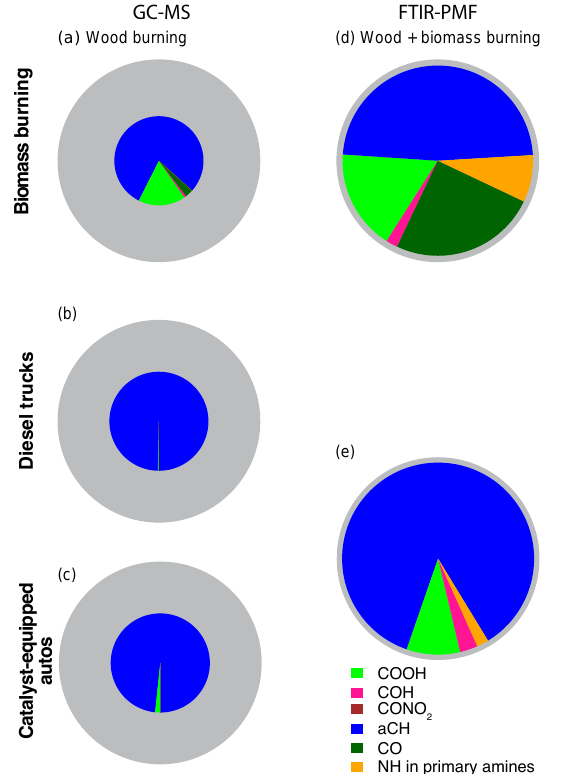
Figure 6. Comparison of the FG distribution of the quantified frac- tion measured by GC-MS ( a , b , c ; Rogge et al., 1998; Rogge et al., 1993) and FTIR-PMF ( d and e ; Hawkins and Russell, 2010) in aerosol emitted by biomass burning (a, d) and vehicle emission (b, c, e) sources. The gray area is the OA fraction unresolved by the two different analytical techniques used (around 80% for GC-MS and around 10% for FTIR). The type of biomass burning is specified in the pie charts (a, d) .